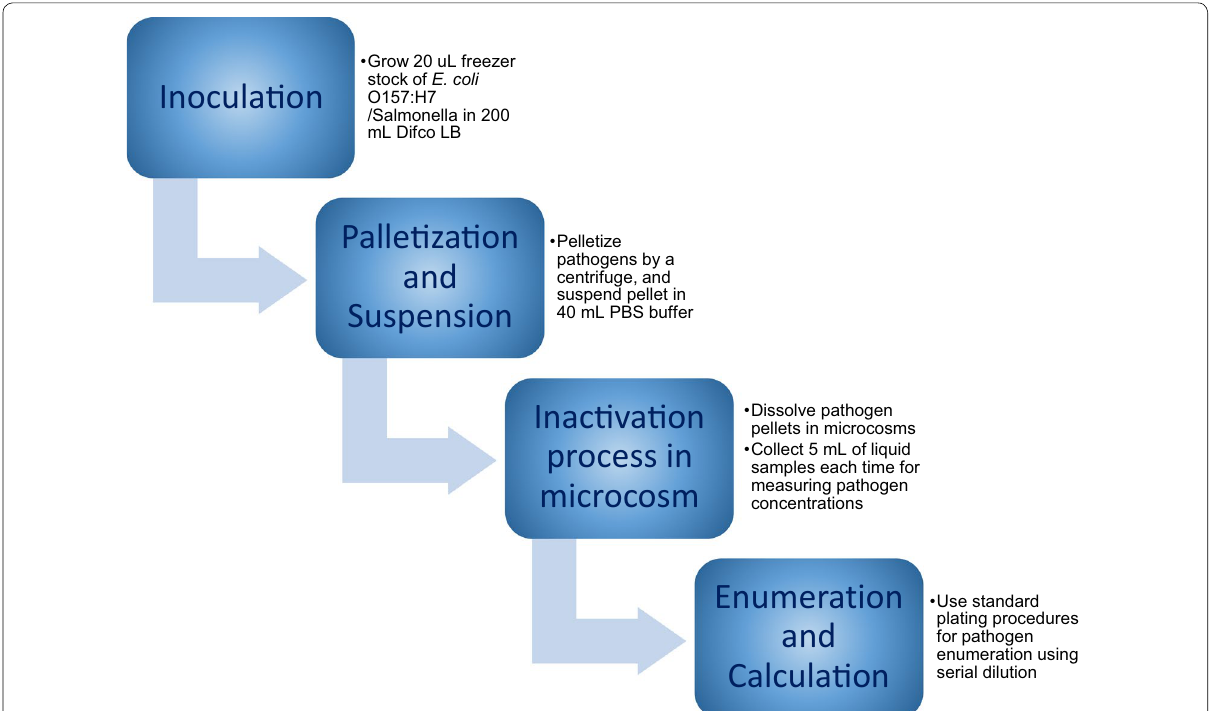
Fig. 2 Steps involved in inactivation study of E. coli O157:H7 and Salmonella in